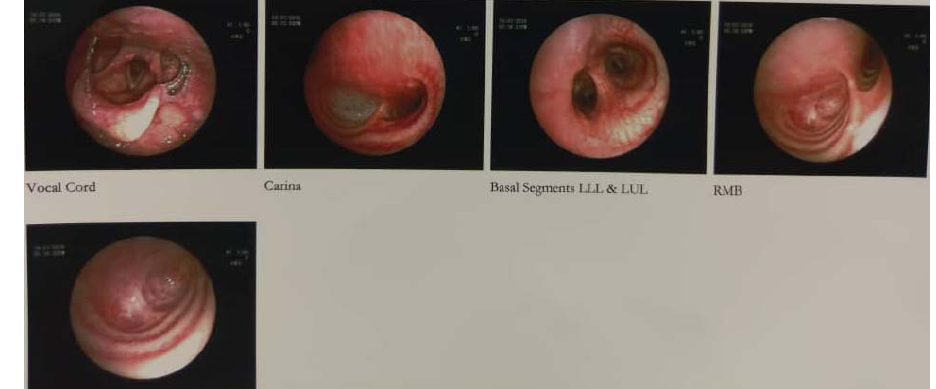
Figure 2. Bronchoscopic view of patient